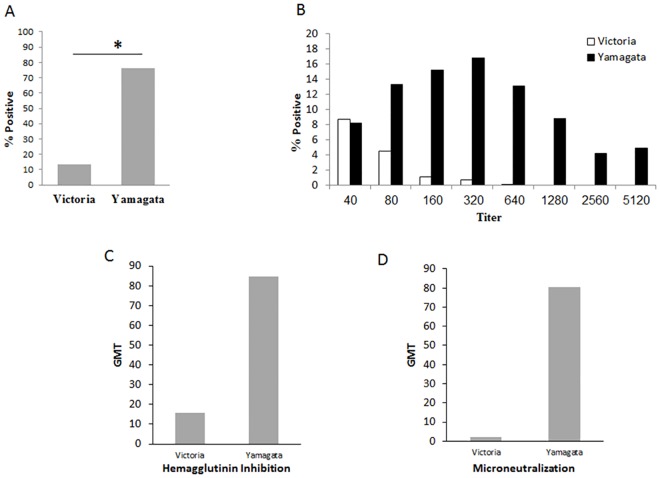
Antibodies against Yamagata were dominant in 2014.Sera were collected from randomly selected individuals and the presence of antibodies against Victoria and Yamagata was detected as described in materials in methods. Summary of positive samples is shown in (A). Shown in (B) is the virus titers and in (C) Geometric Mean Titers (GMT) antibody neutralization of the Israeli circulating influenza B. (D) Microneutralization assays.